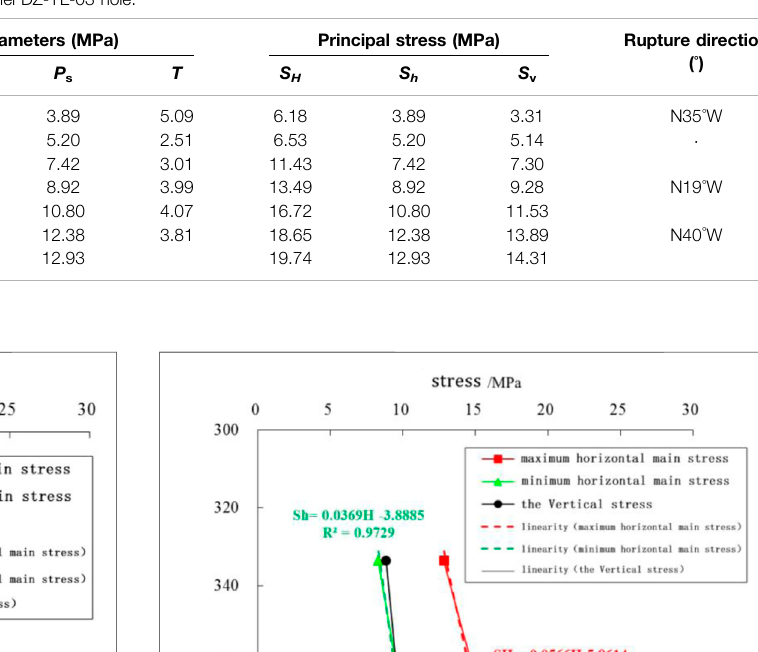
TABLE 1 | Results of hydraulic fracturing in situ stress in YL Tunnel DZ-YL-03 hole.